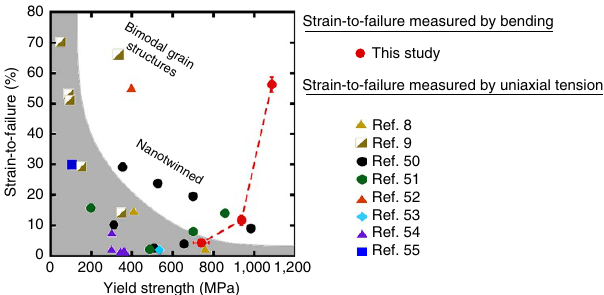
Figure 5 | Strain-to-failure and yield strength for Cu and Cu-based alloys. The vast majority of data fall within the grey envelope, with recent advanced alloys pushing slightly outside this limit. Our Cu-Zr alloy breaks the expected trend, with both higher strength and ductility than the pure Cu sample. All strain-to-failure data comes from material that failed under tensile stresses, either under uniaxial tension (literature data) or from the tensile side of a bending experiment (this study). Literature data are taken from refs 8,9,50–55.